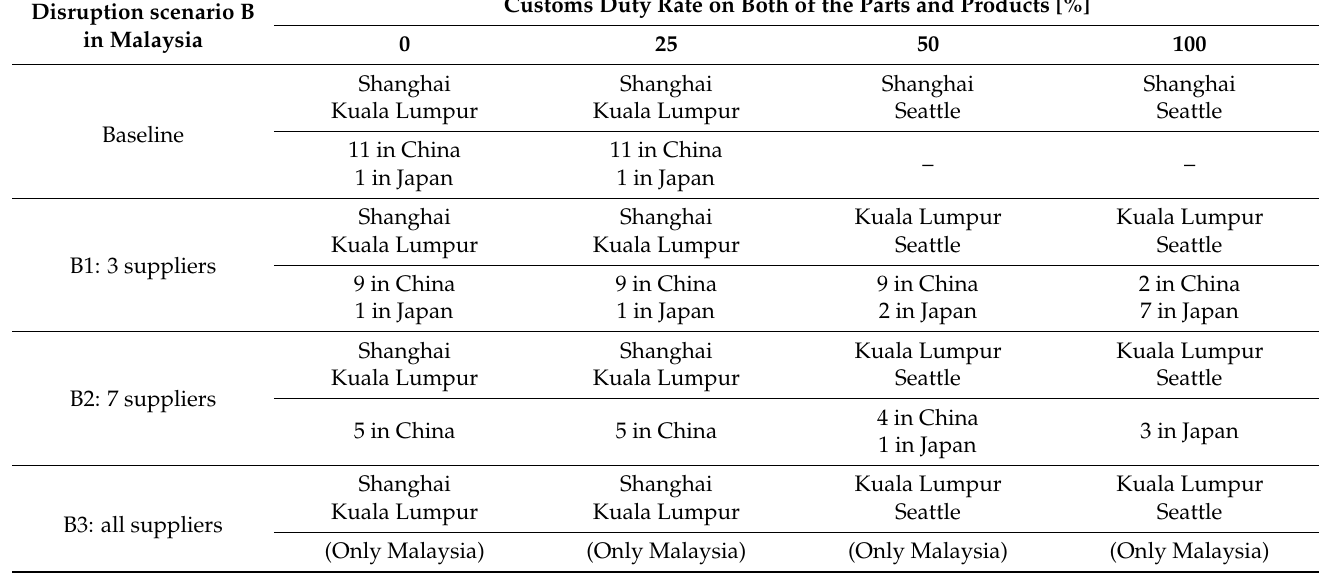
Table 6. The result of the selected factories and the number of suppliers in the country for Kuala Lumpur factory under changes in customs duty